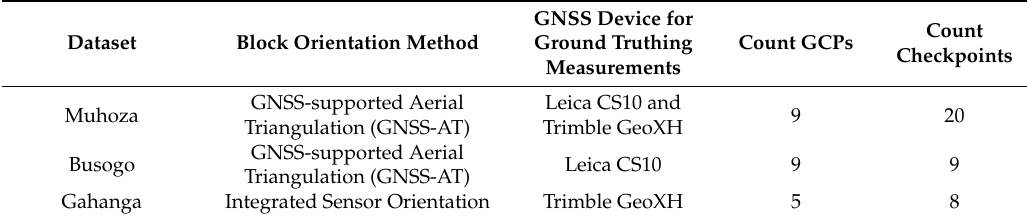
Table 4. Block orientation method and ground truthing information of all datasets.